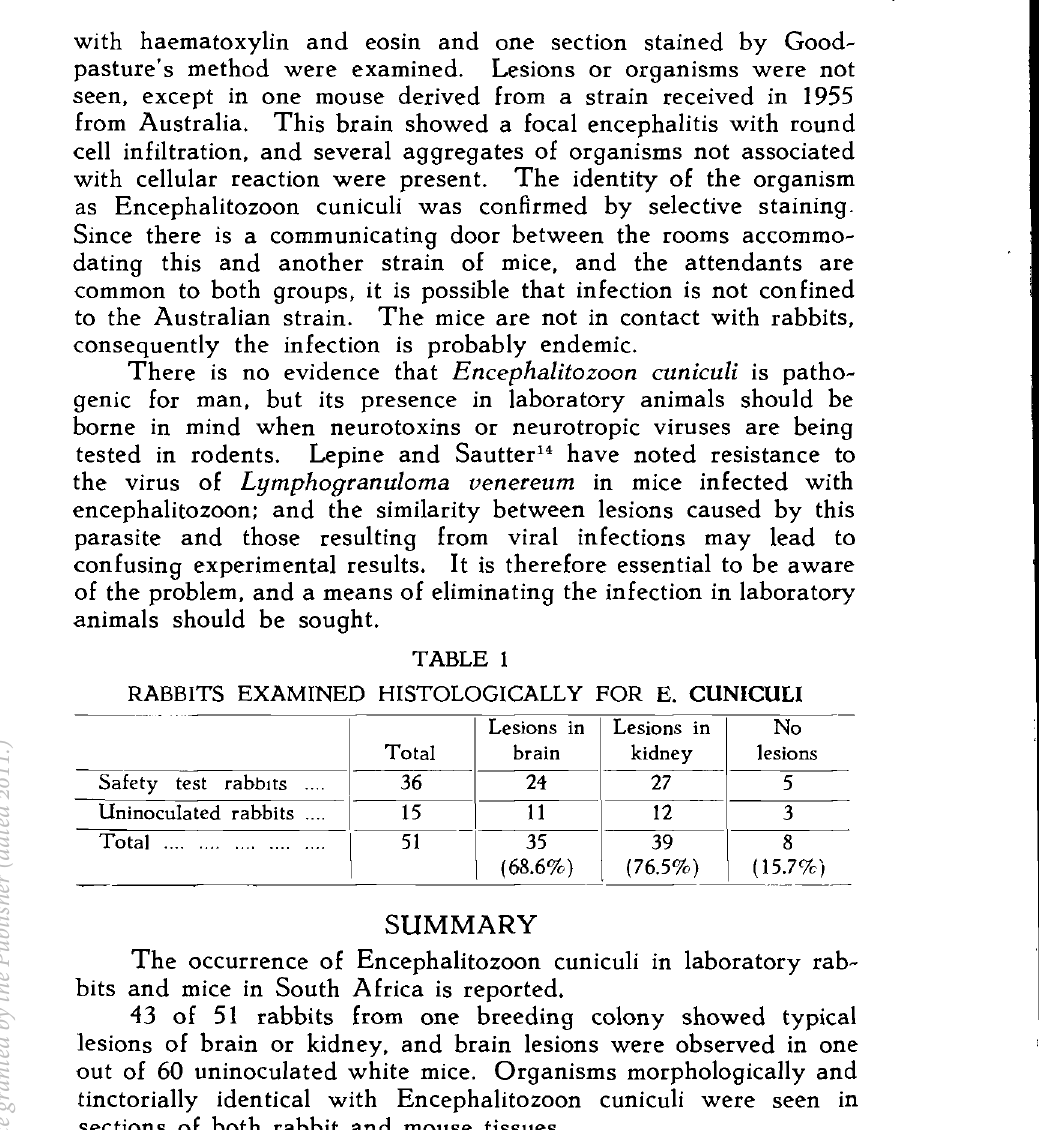
RABBITS EXAMINED HISTOLOGICALLY FOR E. CUNICULI ------ Lesions in Lesions in No Total brain kidney lesions I